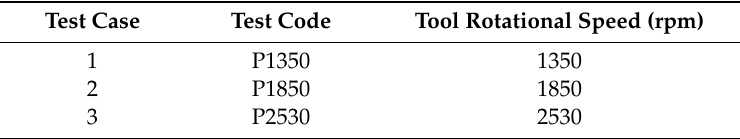
Table 5. Experimental configuration of the friction stir spot welding process.